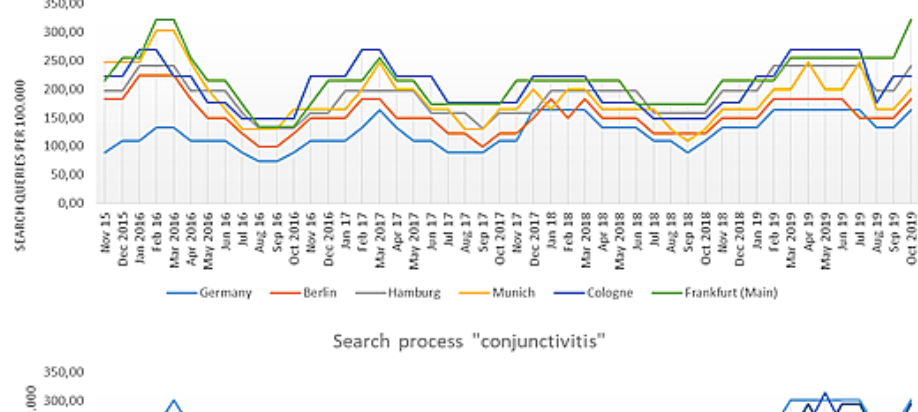
Figure 1. Search process for the German term for conjunctivitis (“Bindehautentzündung”) and 714 associated terms. (A) Search history of the term “conjunctivitis” from November 2015 to October 2019 in Germany and in the cities Berlin, Hamburg, Munich, Cologne, Frankfurt (Main), Stuttgart, Leipzig, Hannover, Nuremberg, Freiburg, Rostock, and Kassel per 100,000 inhabitants. (B) Same representation as (A) but for the search process of the term “conjunctivitis” and the 714 associated